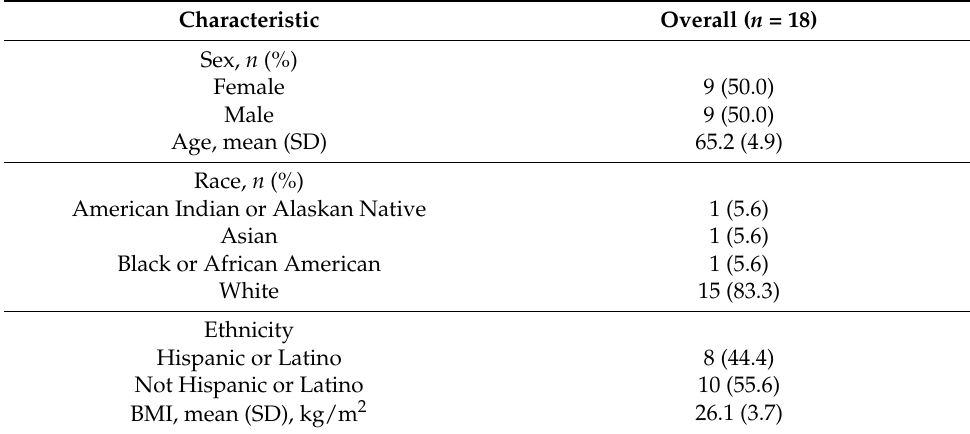
Table 1. Baseline characteristics of study